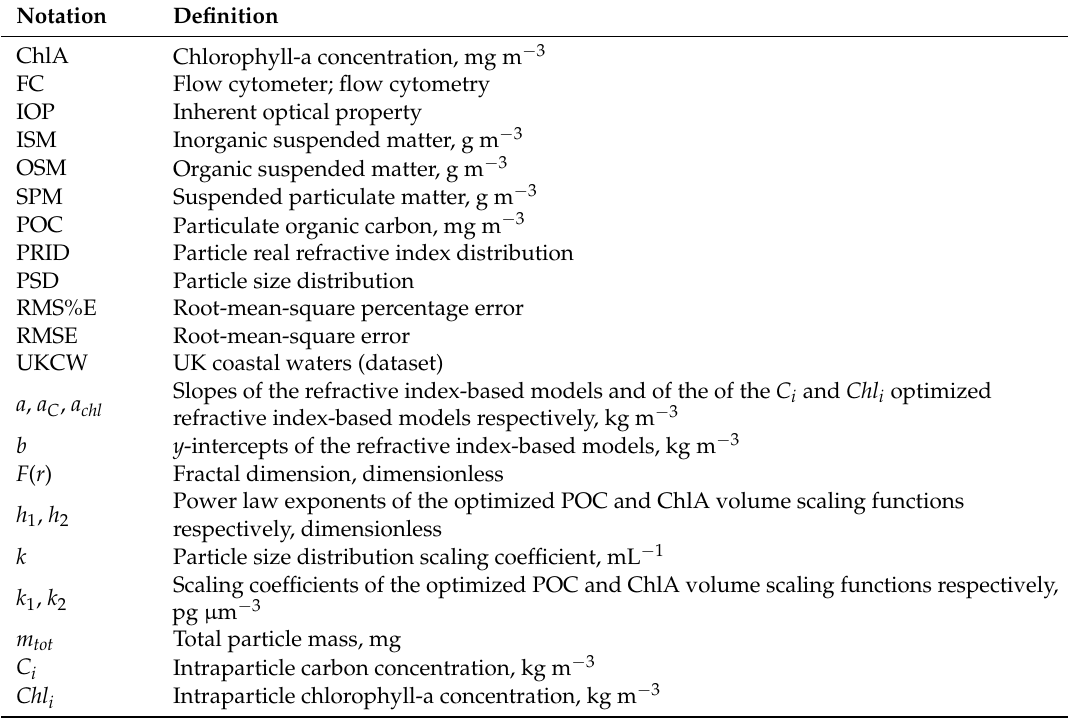
Table 1. Abbreviations and notations used in this